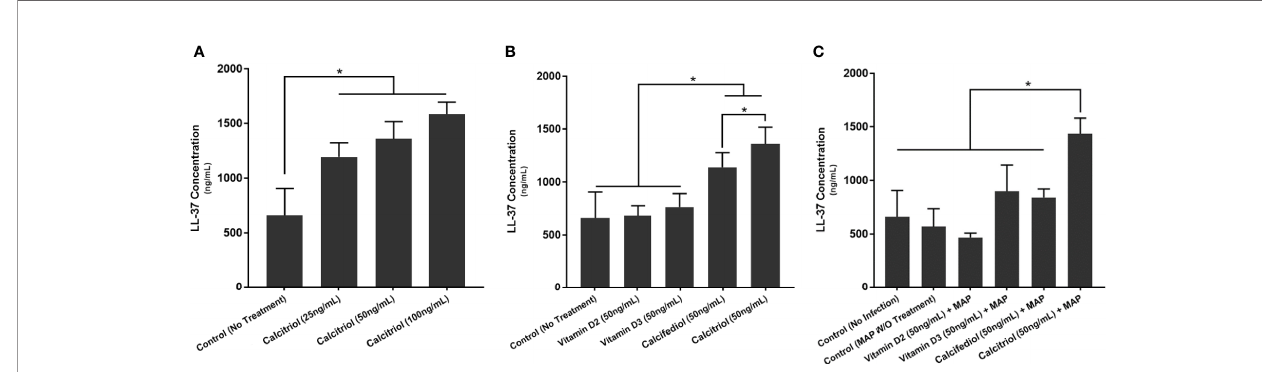
FIGURE 3 | Effects of different forms of vitamin D (A) and different concentrations of calcitriol (B) on LL-37 production in the presence of MAP infection (C) . Cytokine concentration was quanti fi ed using the Ella system (ProteinSimple). *Indicates P-value of less than 0.05.